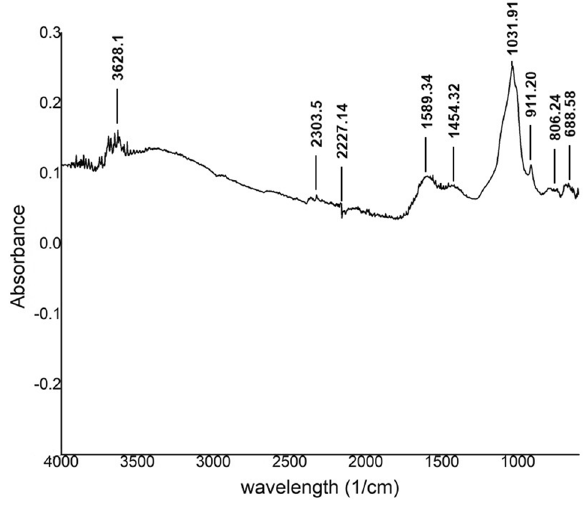
Fig. 3 FTIR spectrum of